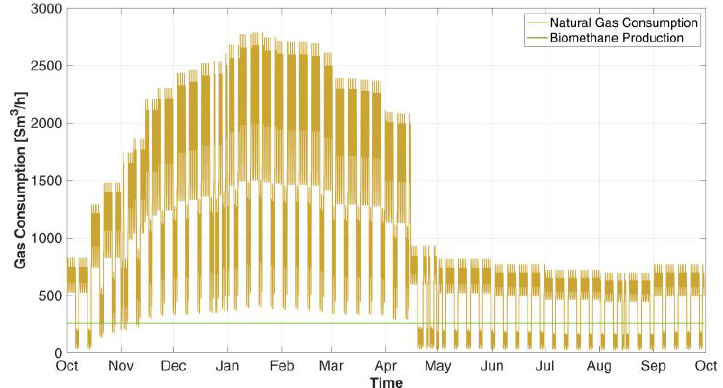
Figure 4. Overall natural gas consumption profile on an hourly basis for the entire year in comparison with the biomethane production rate that is available in the area.